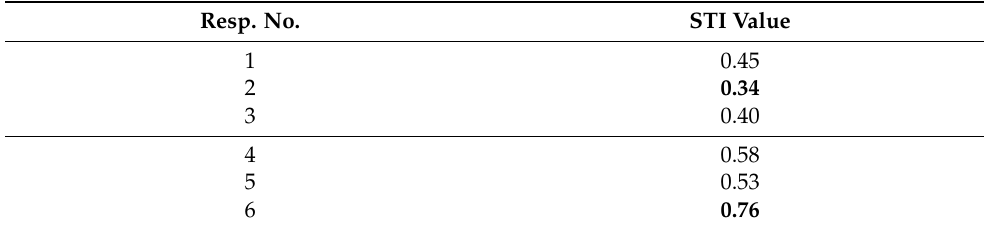
Table 2. Impulse responses used in the study and corresponding STI values (the lowest and the highest STI value are marked in bold).